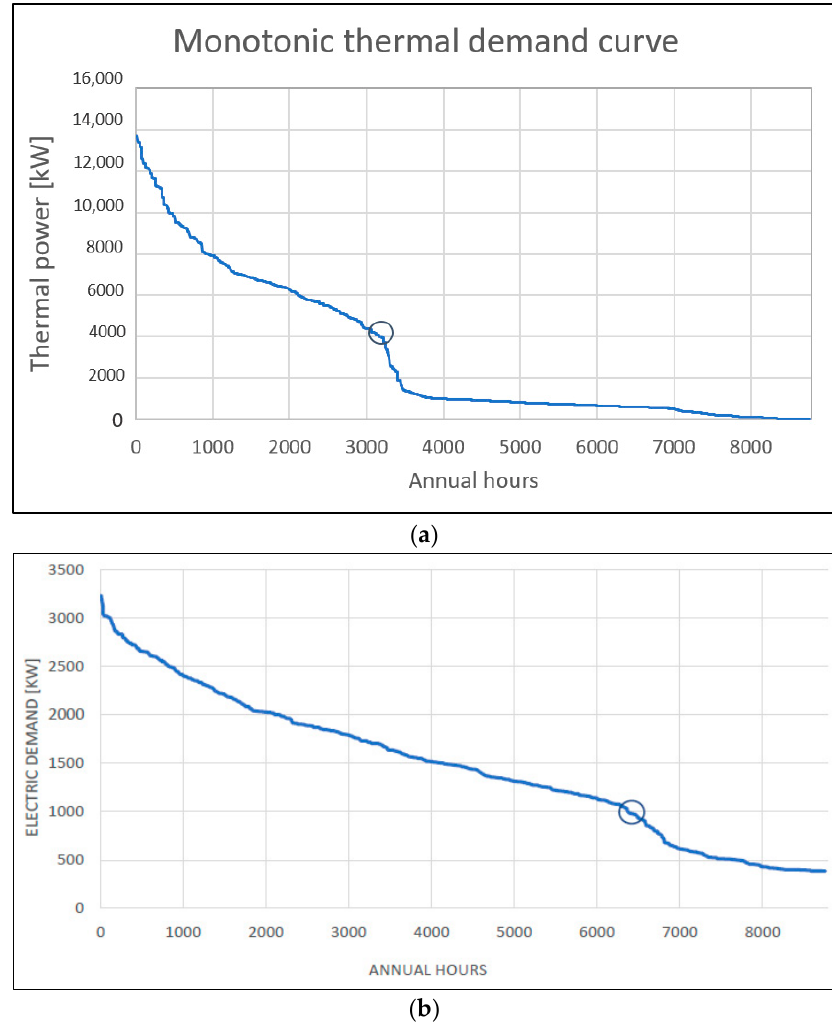
Figure 4. Monotonic annual demand curve. Graphical representation of demand during the year. ( a ) Annual monotonic thermal demand curve. ( b ) Annual monotonic electricity demand